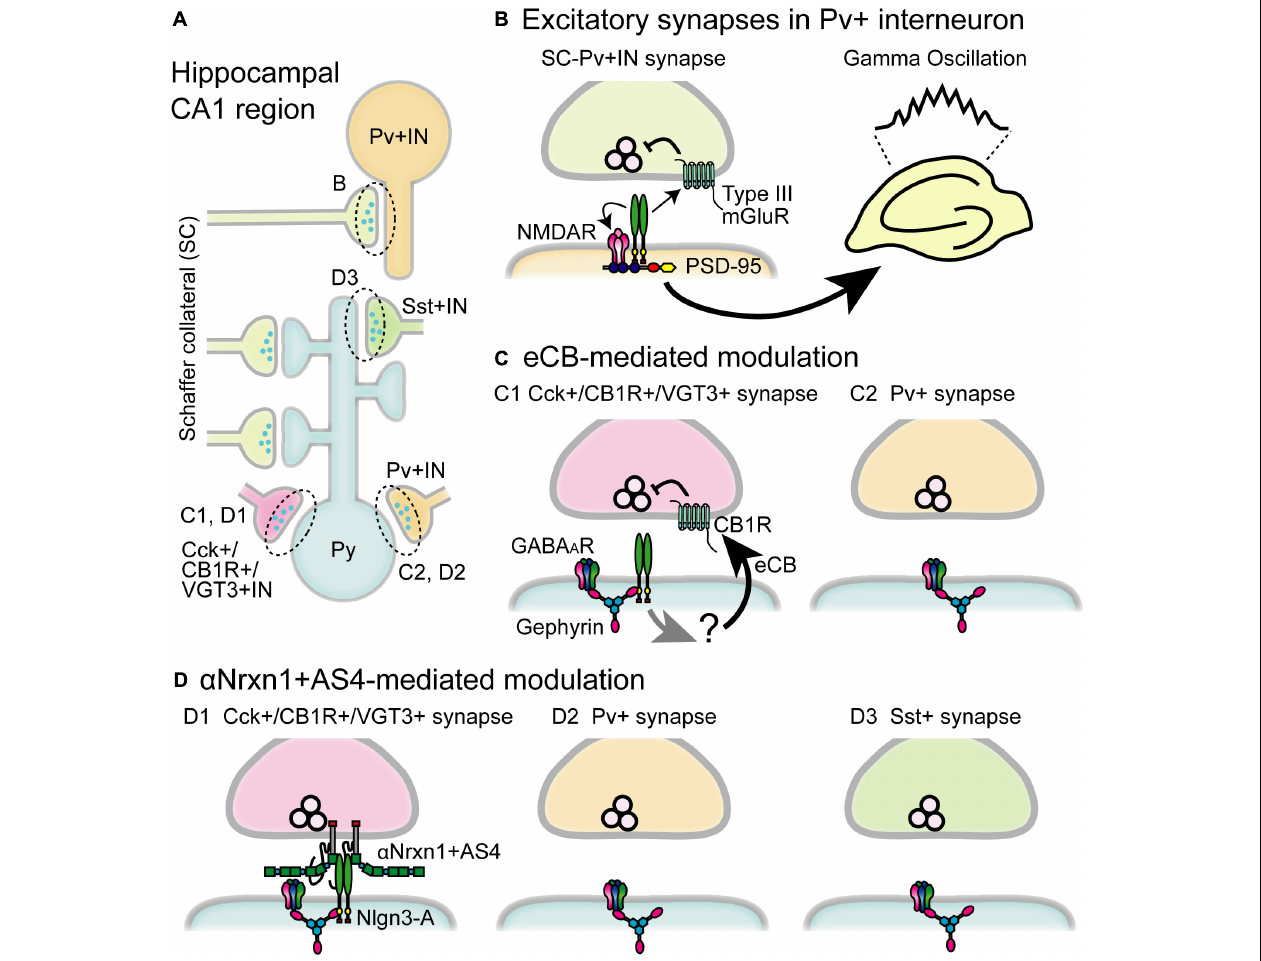
FIGURE 4 | Schematic diagram of the circuit-specific Nlgn3 functions in the hippocampal CA1 region. (A) Schematic microcircuits in the hippocampus. Schaffer collaterals (SC) form excitatory synapses on both pyramidal cells (Py) and parvalbumin+ interneurons (Pv+ IN). Distinct classes of interneurons including cholecystokinin+/cannabinoid CB1 receptor+/vesicular glutamate transporter type 3+ interneurons (Cck+/CB1R+/VGT3+ IN), Pv+ interneurons and somatostatin+interneurons (Sst+IN) form inhibitory synapses on pyramidal cells. (B) Multiple modes of Nlgn3 regulation in Pv+ interneurons shape hippocampal network activity such as gamma oscillation. Postsynaptic Nlgn3 at SC-Pv+IN synapses regulates NMDA receptor function and retrogradely suppresses release probability through presynaptic group III mGluRs (Polepalli et al., 2017). (C) Inhibitory input-specific Nlgn3 regulation. Postsynaptic Nlgn3 regulates Cck+ but not Pv+ synaptic strength via the activation of tonic endocannabinoid (eCB) signaling (Foldy et al., 2013). (D) Inhibitory input-specific Nlgn3 regulation through trans-synaptic interaction with α Nrxn1+AS4. Nlgn3 is selectively expressed at inhibitory synapses expressing VGT3 and CB1, and regulates inhibitory synaptic transmission with presynaptically expressed α Nrxn1+AS4 (Uchigashima et al., 2020a). GABA A R, GABA A